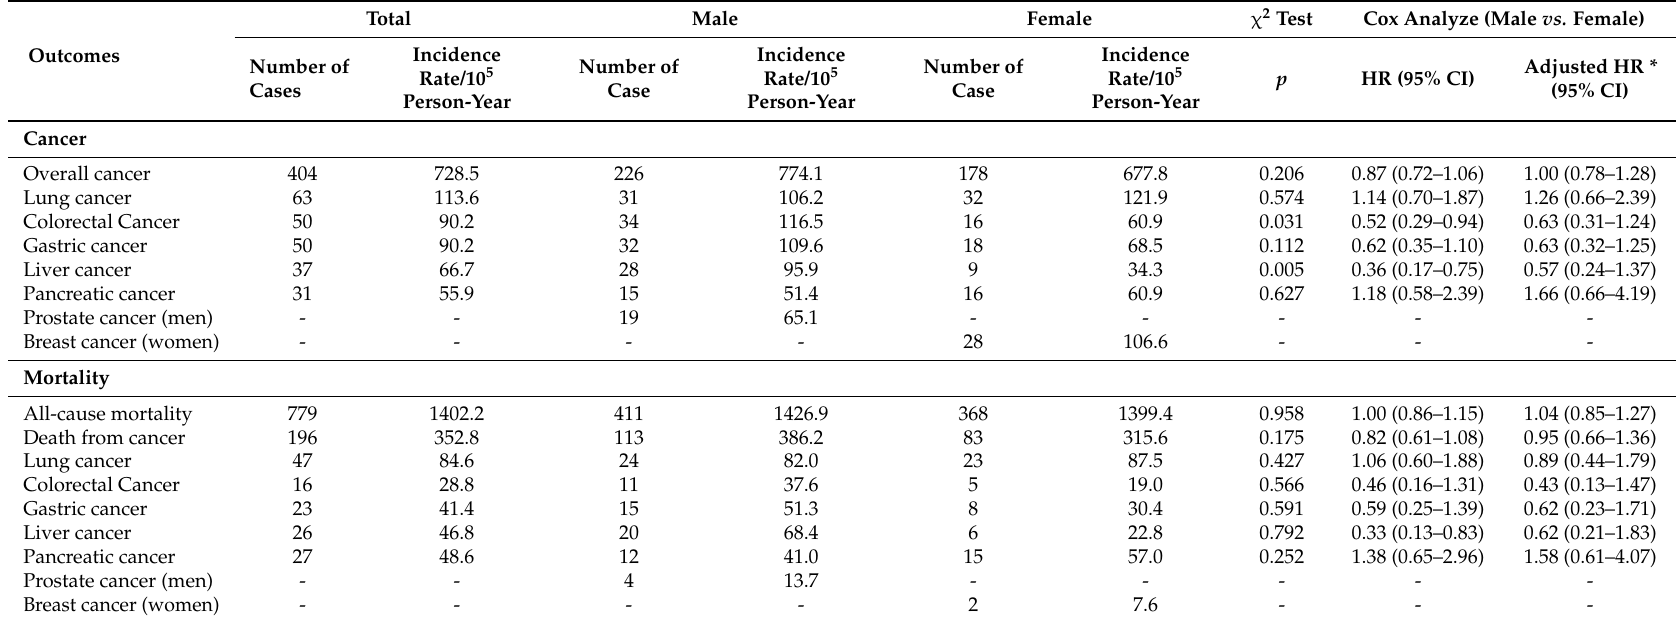
Table 3. Incidence rate of cancer and mortality among diabetic